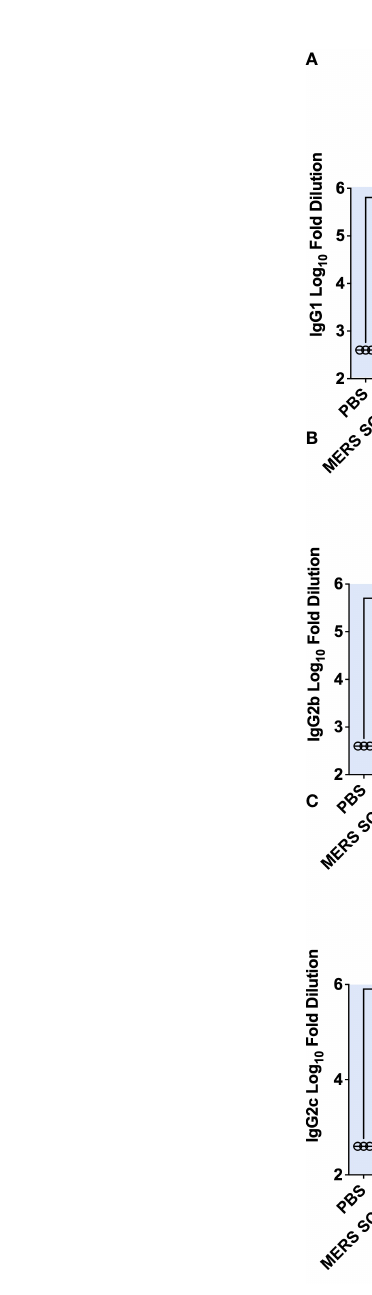
formulations containing QS21, and IL-2 + were very rarely detected (Figure 4E, F). Interestingly, when immunized with a higher antigen dose, the proportion of IFN Ɣ + CD8 + were more frequent for all experimental groups immunized with formulations containing QS21 (Figure S3B).